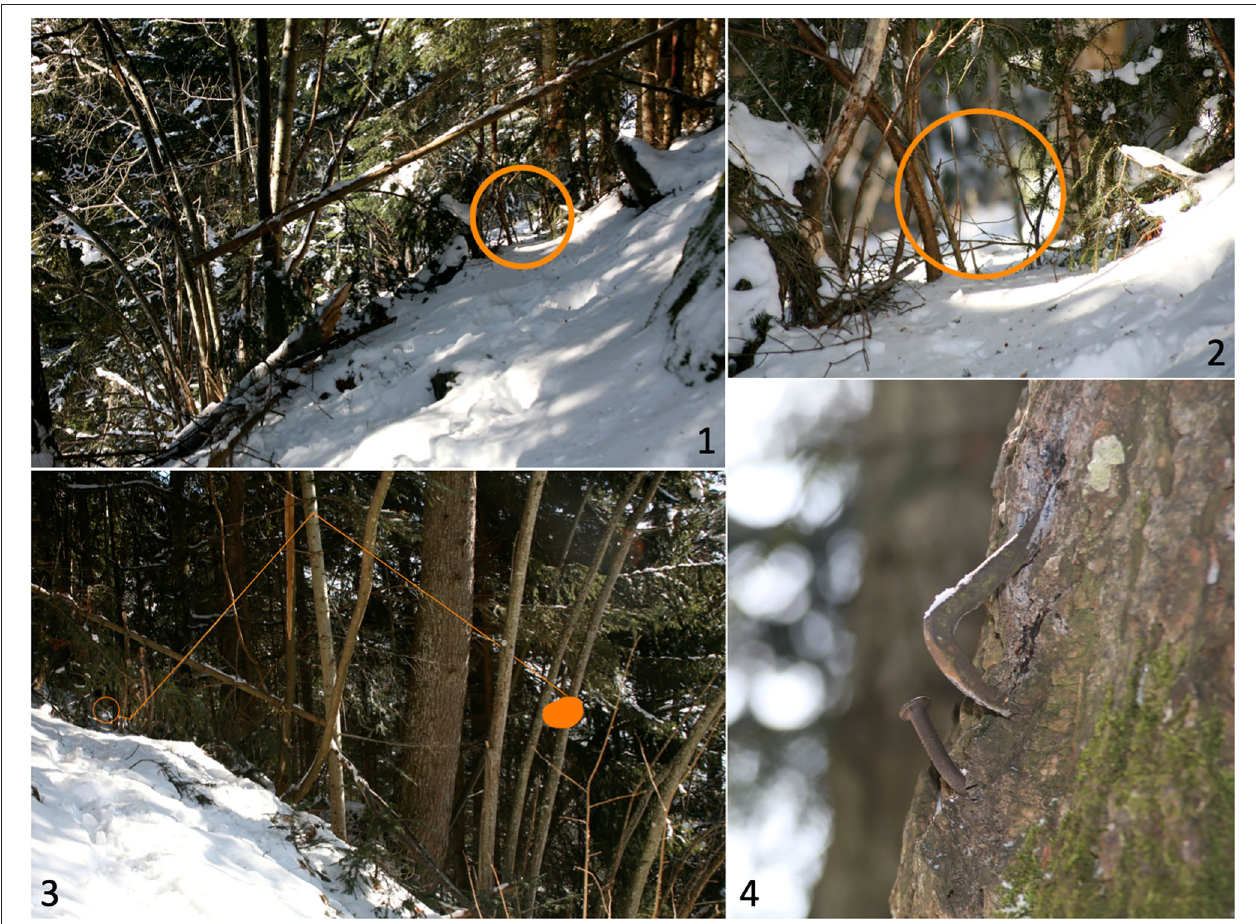
FIGURE 3 | An active neck-snare trap discovered in 2015 in the lynx entrance corridor into Valais from the Prealps. (1) This illegal capture system has been installed in an obligate passage along a wildlife trail; branches have been added in the surroundings to augment the channeling effect, i.e., to steer the lynx toward the snare (a bike brake wire) located within the orange circle; (2) a close-up view of the neck snare itself (cable visible within the orange circle); (3) the trapping system viewed from the other side: the position of the snare is again indicated by the orange circle; the cable bending the system goes through a hook positioned high on the thin tree trunk and goes down toward the right; the system is put under tension with a large stone (highlighted in orange on the right); (4) at an inactive trapping site, sometimes only the middle hook positioned high above the ground is visible. A video showing another active system can be obtained from the authors upon request.